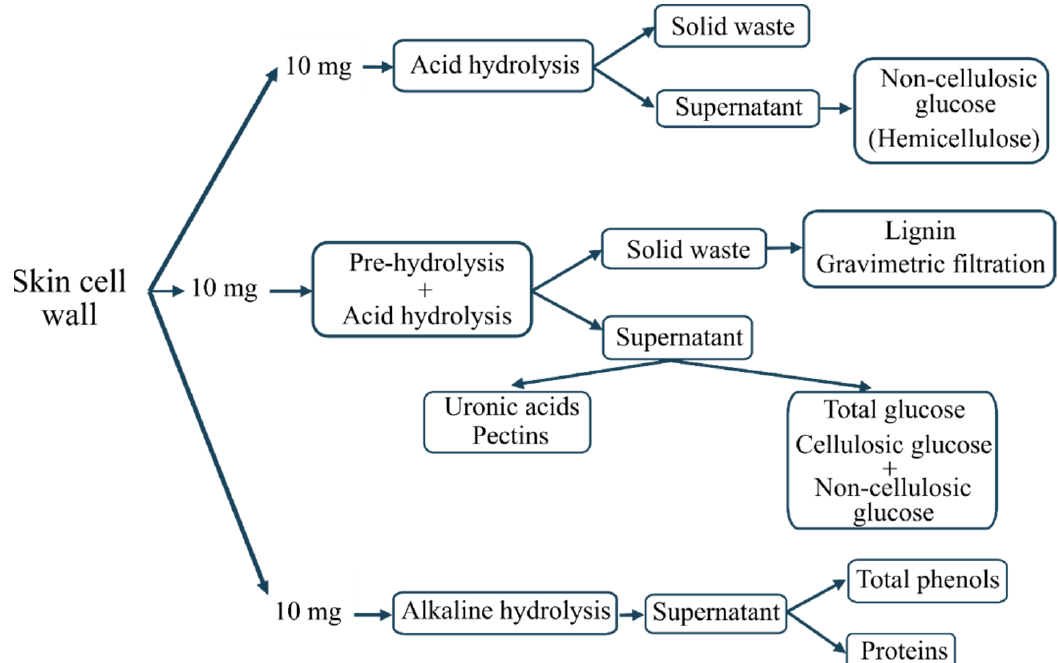
Figure 2. Skin cell wall analysis protocol.